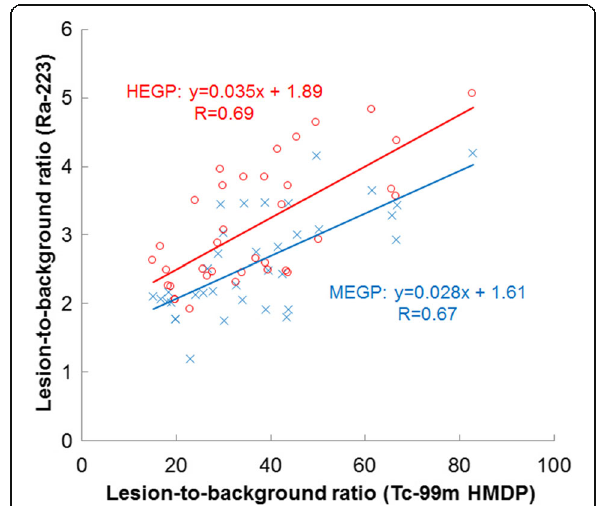
Fig. 6 Relationship of lesion-to-background ratio between Tc-99m HMDP SPECT and Ra-223 SPECT with the MEGP or HEGP collimators. MEGP medium-energy general purpose, HEGP high-energy general purpose, HMDP hydroxymethylene diphosphonate